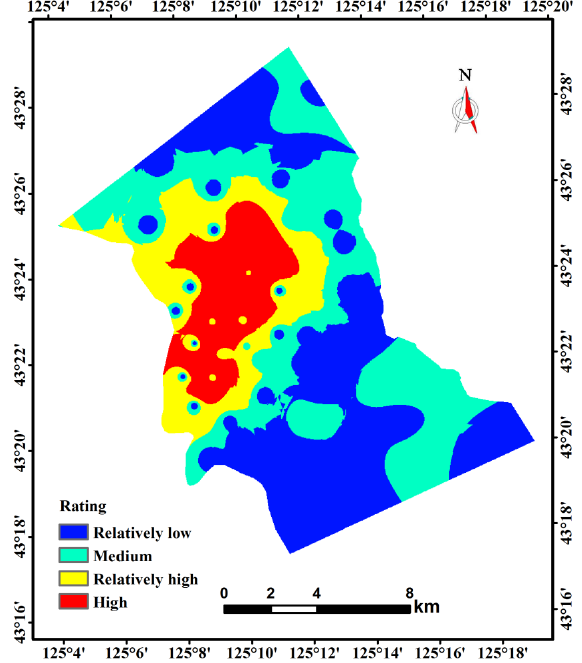
Water 2022 , 14 , x FOR PEER REVIEW Figure 6. Groundwater function value assessment rating mapping. Figure 6. Groundwater function value assessment rating mapping.